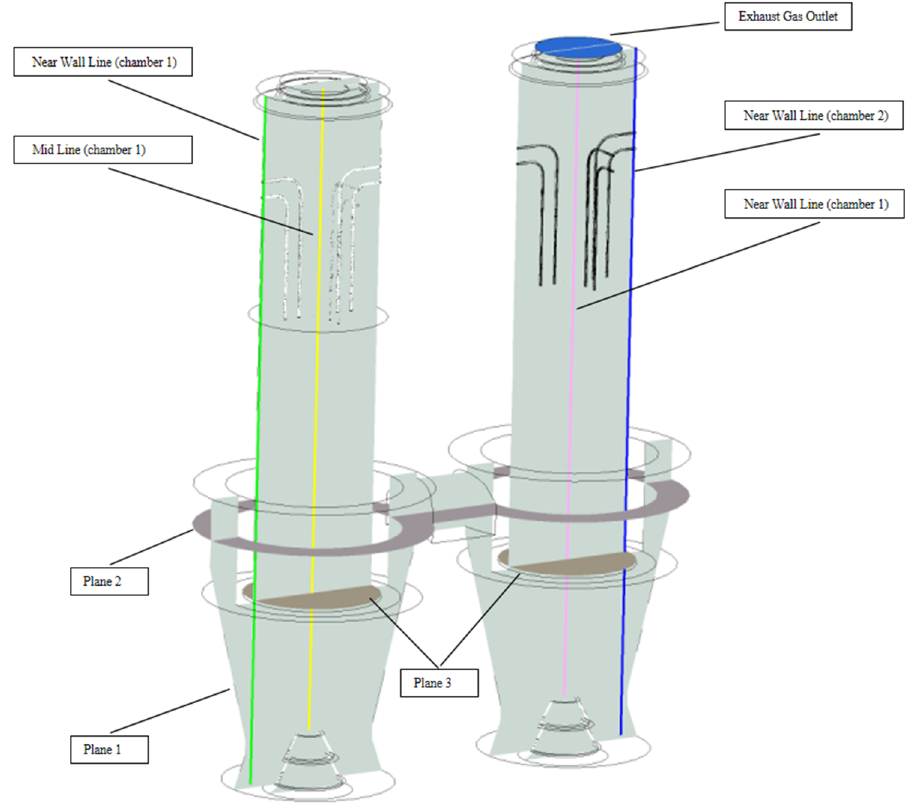
Figure 3. Schematic diagram of the analysis position.